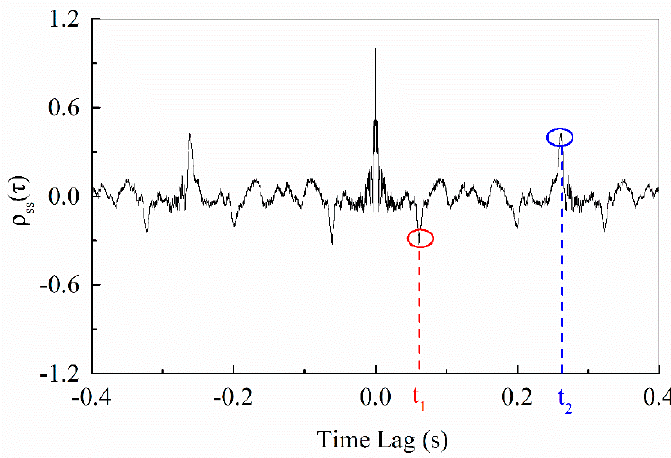
Figure 4. Autocorrelation curve of collected acoustic signals.